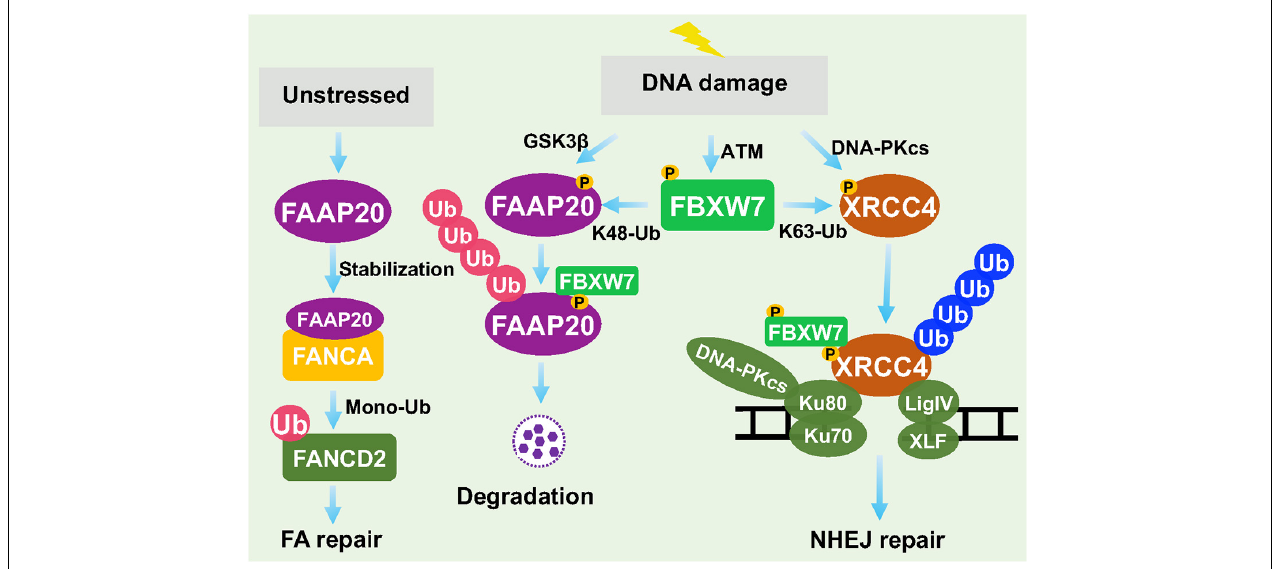
FIGURE 4 | FBXW7 in regulation of DNA repair. Under unstressed condition, FAAP20 binds FANCA to facilitate mono-ubiquitylation of FANCD2. Upon DDR, FAAP20 was phosphorylated by GSK3 β to facilitate FBXW7 binding and ubiquitylation. On the other hand, DNA-PKcs phosphorylated XRCC4, whereas ATM phosphorylated FBXW7. At the damage site, FBXW7 promoted XRCC4 polyubiquitylation via the K63 linkage to facilitate recruitment of Ku70/Ku80 for NHEJ repair.